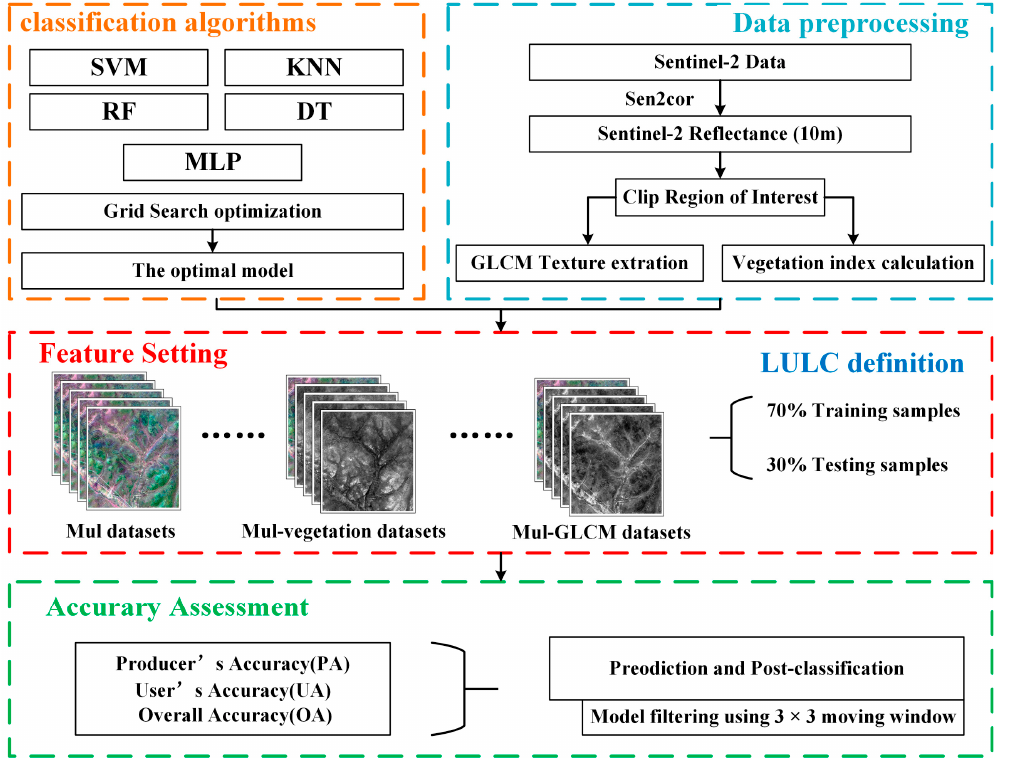
Figure 2. The methodological workflow.